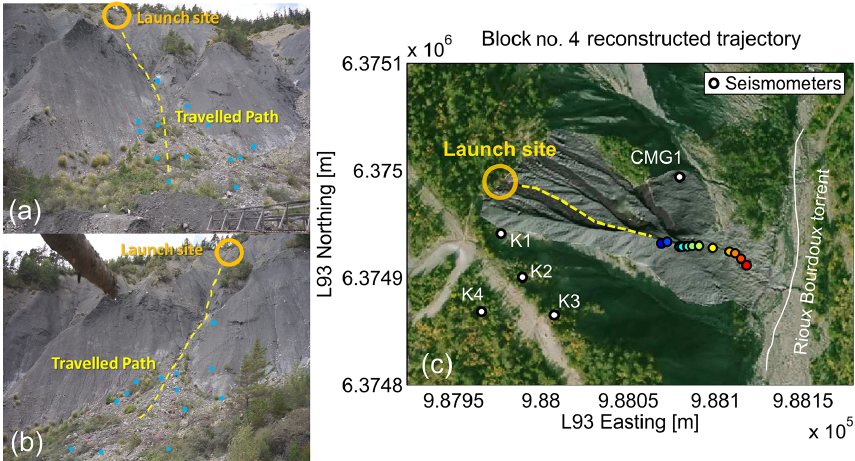
Figure 1. View from (a) the first and (b) the second video cameras deployed at the bottom of the slope. The ground control points are indicated by blue points. (c) Trajectory reconstruction for block 4 on the DEM, built from lidar acquisition, superimposed on an orthophoto of the Rioux-Bourdoux slopes. Each point indicates the position of an impact and the colour gradient represents the chronology of these impacts (blue for the first impact and red for the last one). K2 is a three-component short-period seismometer and K1, K3 and K3 are vertical-only seismometers. CMG1 is a broad-band